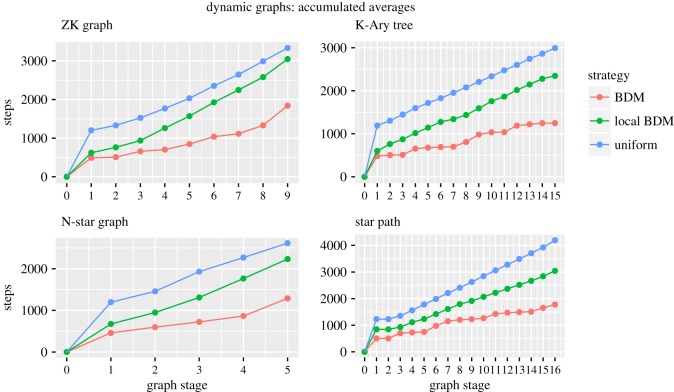
Each point of the graph is composed of the average accumulated time from 100 samples. All evolutions were carried out with 1-bit shifts (mutations).